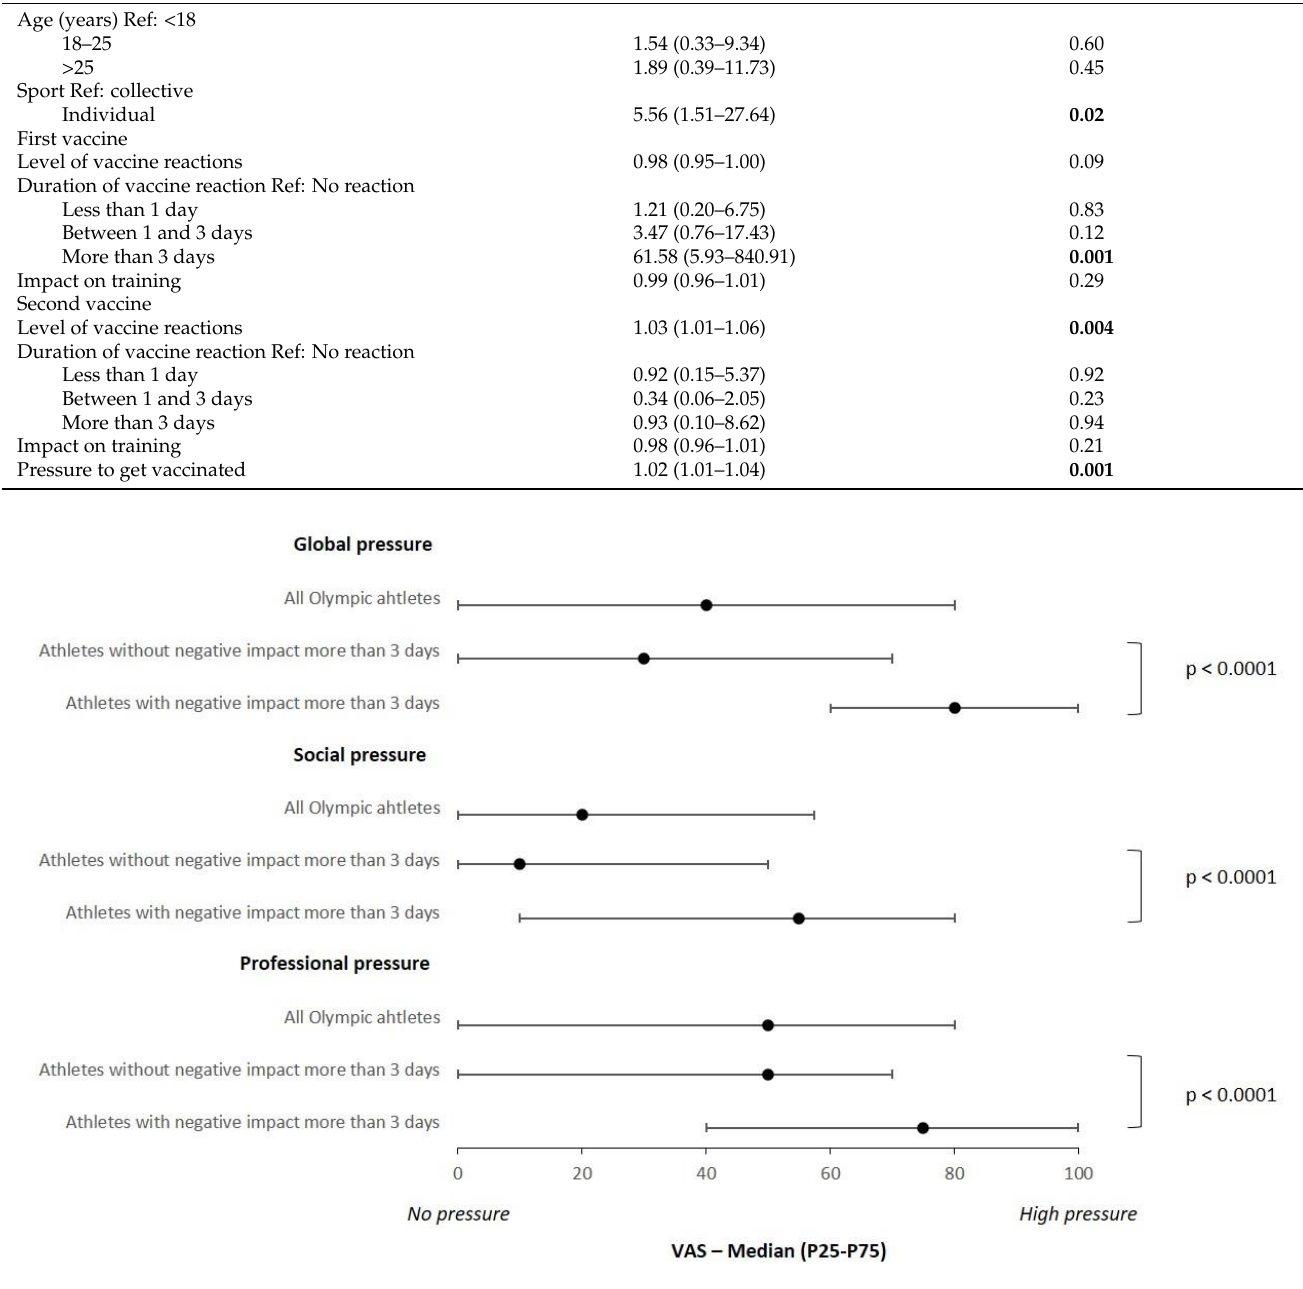
Figure 2. Perceived global, social and professional pressure to get vaccinated on a 100-unit visual analog scale